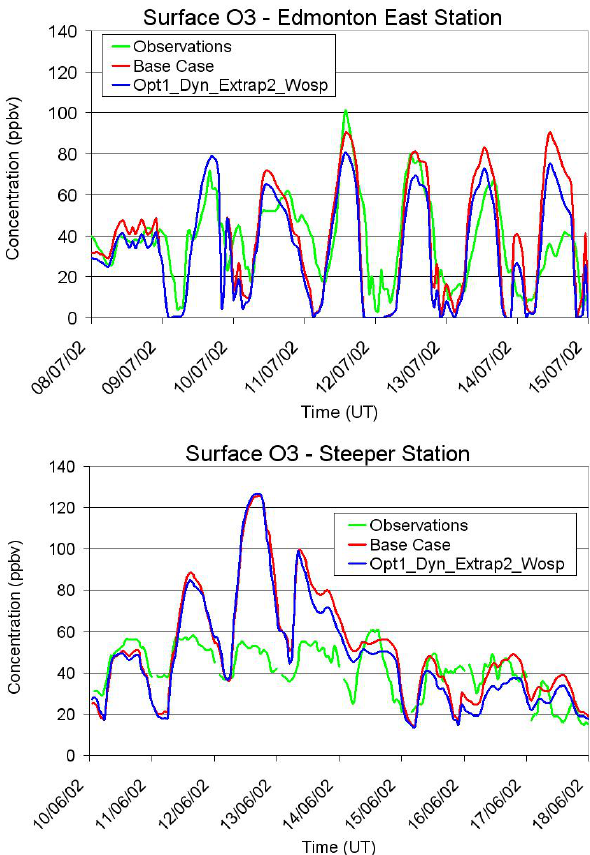
Fig. 13. Time series of ozone at (a) Edmonton East, show- ing typical comparison between model and observations, 8 to 15 July 2002. (b) Comparison during downward mixing event, 10 to 18 June 2002.